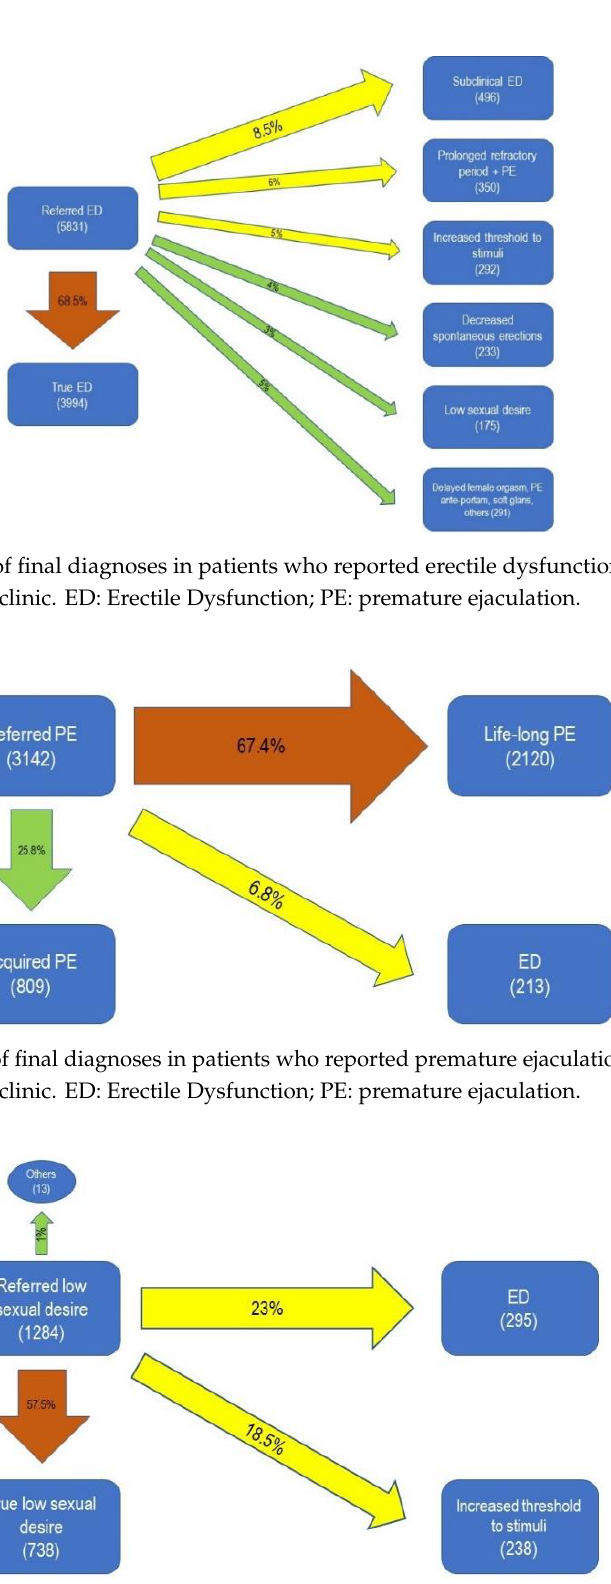
Figure 3. Prevalence of final diagnoses in patients who complained of hypoactive sexual desire disorder (HSDD) at the first visit to the andrology clinic. ED: Erectile Dysfunction; HSSD: Hypoactive Sexual Desire Disorder; Others: delayed female orgasm, prolonged refractory period and PE, decreased spontaneous erections, soft glans.